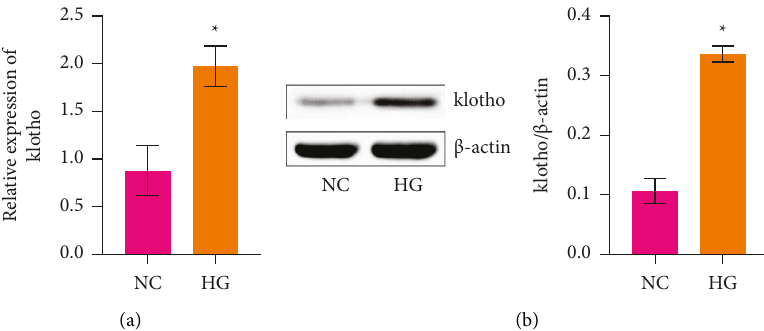
Figure 1: Klotho was highly expressed in HTR-8/SVneo cells induced by HG. (a) RT-qPCR of klotho levels. (b) Western blot of klotho levels. ∗ p < 0 . 05 compared with the NC group.